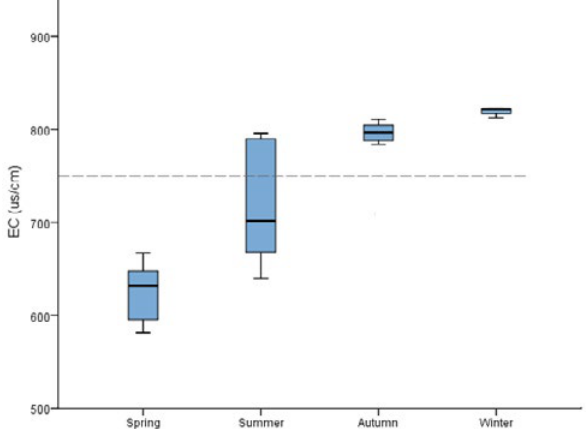
Fig. 3: Seasonal variation of EC of the studied reservoir (EC 750 µs/cm ≈ TDS 500 mg/L as desired limit of drinking water standard)